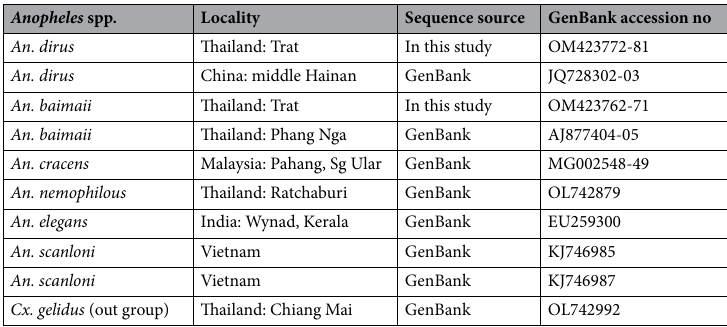
Table 2. GenBank accession numbers of the COI of Anopheles dirus and An. baimaii sequences in this study and reference mosquito species used for construction of the phylogenetic tree.